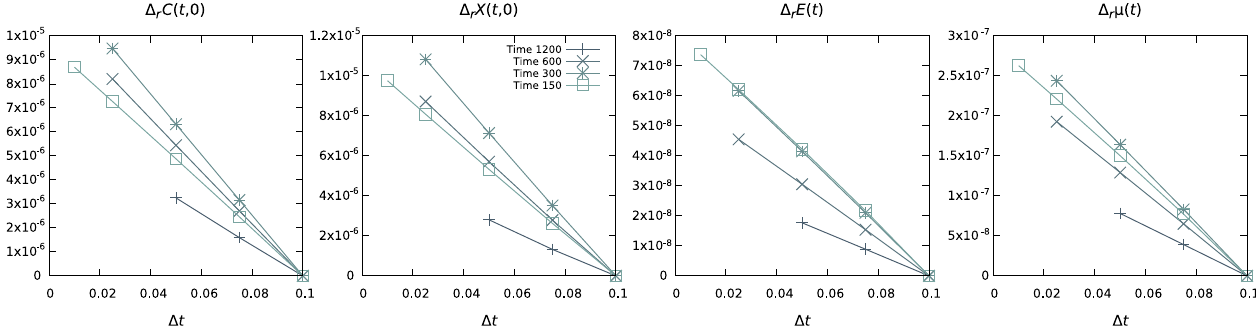
26. Relative errors, as defined in Eq. (F1), for C ð t; 0 Þ , χ ð t; 0 Þ , E ð t Þ and μ ð t Þ , obtained in the integration of the dynamical equations for the ( 3 þ 4 ) spin with T ¼ T . The dependence is linear in the integration step Δ t , and the resulting integration error in MCT using Δ t ¼ 0 . 1 is very small compared to the precision needed in the asymptotic evaluation of the